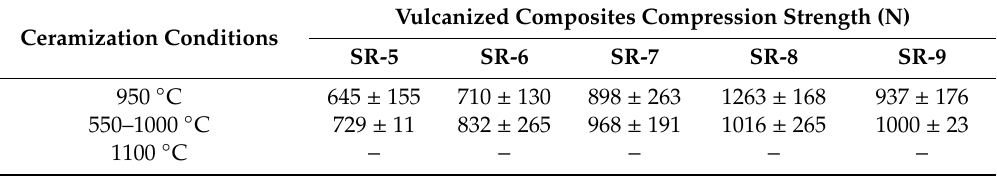
Figure 19. ( A ) Composites SR-5 ÷ 9 before ceramization, ( B ) Composites SR-5 ÷ 9 after ceramization at a temperature of 950 ◦ C (programme 1), ( C ) Composites SR-5 ÷ 9 after ceramization at a temperature of 550–950 ◦ C (programme 2), ( D ) Composites SR-5 ÷ 9 after ceramization at a temperature of 1100 ◦ C (programme 3), ( E ) Composite SR-7 after ceramization at a temperature of T = 950 ◦ C, ( F ) Composite SR-7 after ceramization at a temperature of T = 550–950 ◦ C, ( G ) Composite SR-7 after ceramization at a temperature of T = 1100 ◦ C. Table 8. Compression strength of the ceramized studied